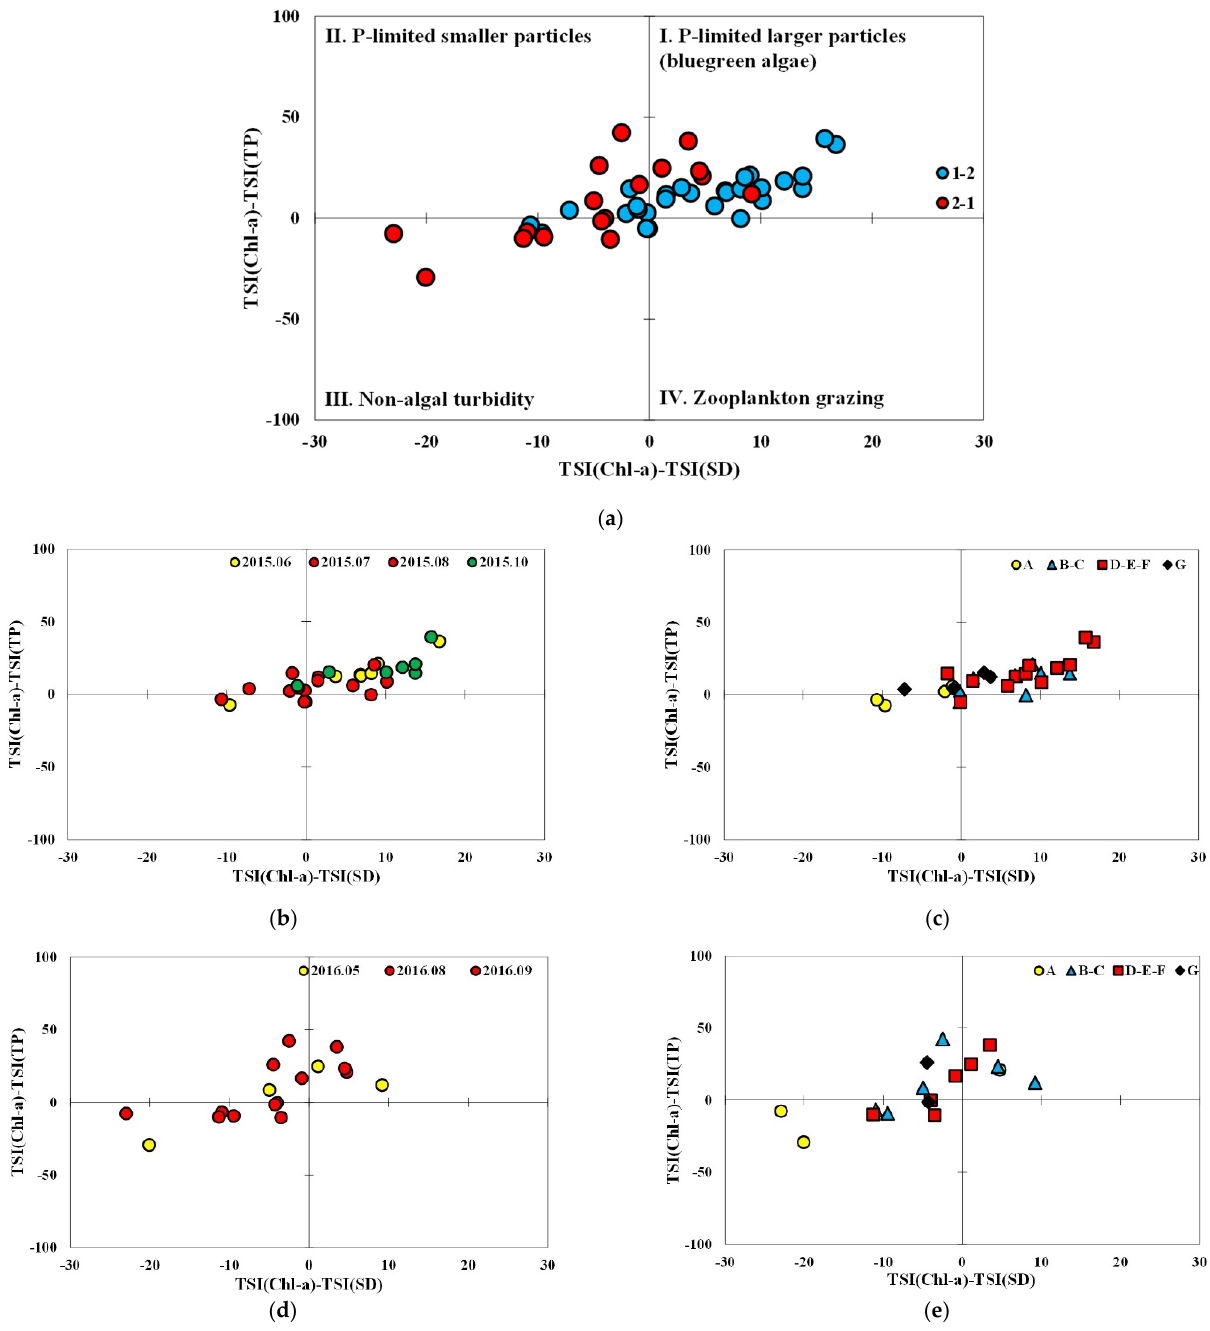
Figure 6. Variations in trophic state index deviation in ( a ) subperiod 1-2 and 2-1, and with ( b ) seasons and ( c ) locations in subperiod 1-2, and ( d ) seasons and ( e ) locations in subperiod 2-1.